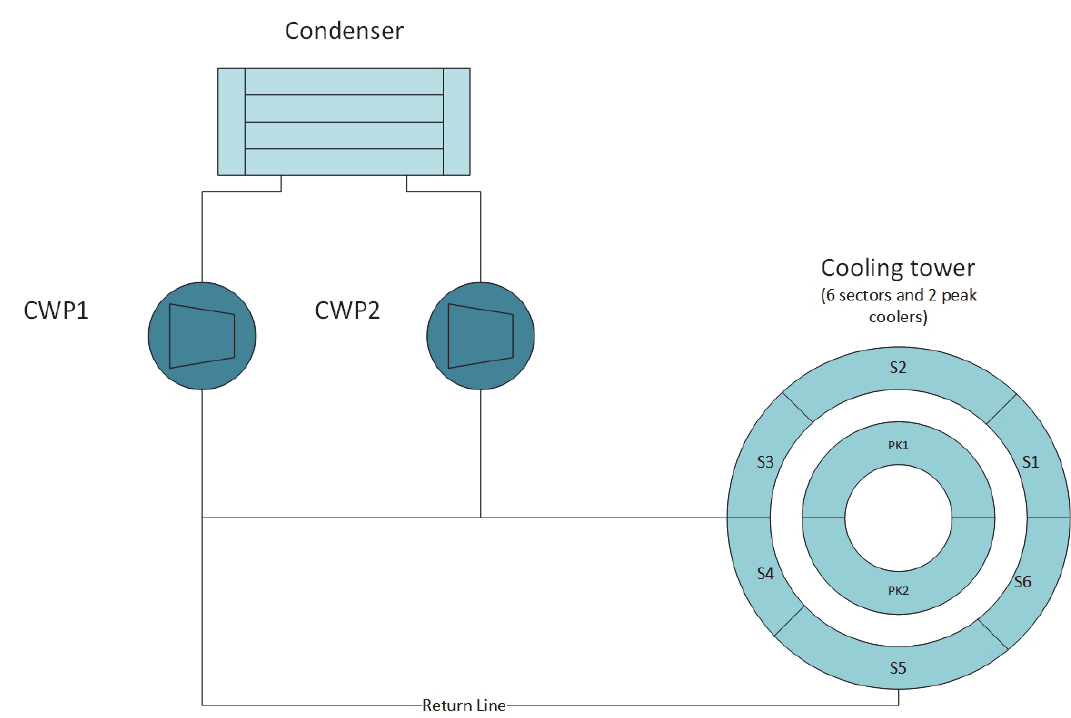
Fig. 2. Main cooling system